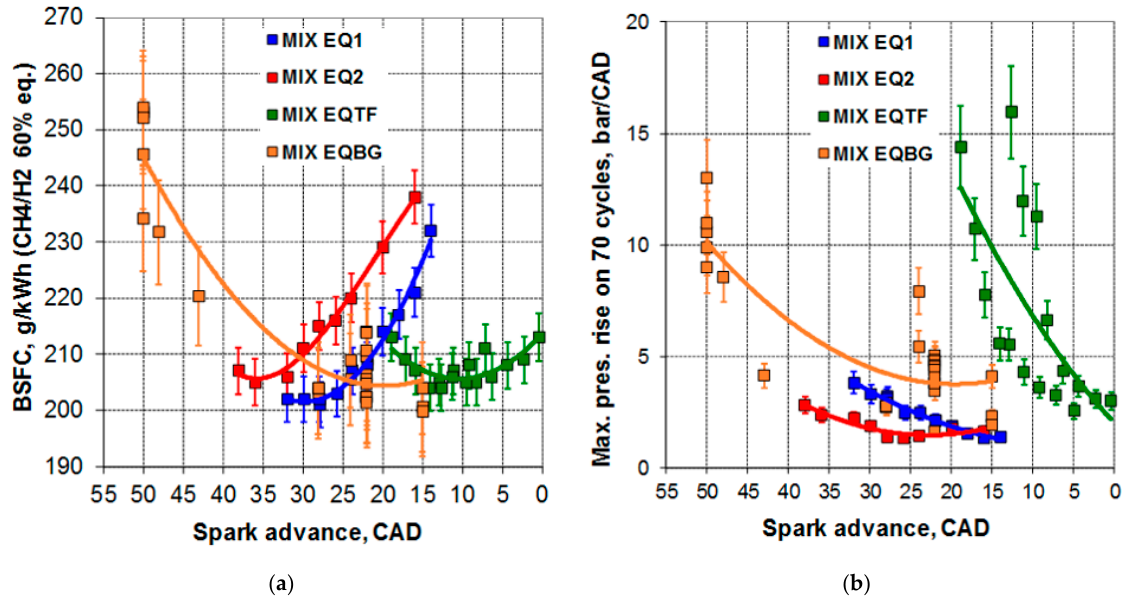
Figure 10. Different SA data for minimum ignition energy operation with the equivalent mixtures at 1500 rpm and MAP 1250 mbar: ( a ) BSFC; ( b ) maximum pressure rise over 70 consecutive cycles.